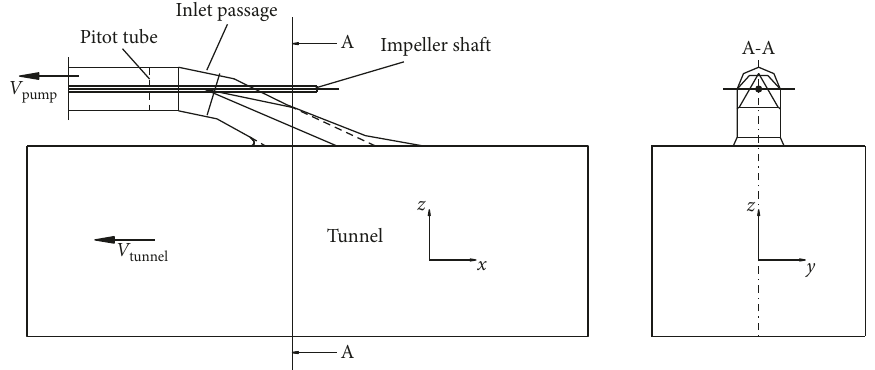
Figure 6: Sketch of the test setup with inlet mounted on top of the cavitation tunnel [1].